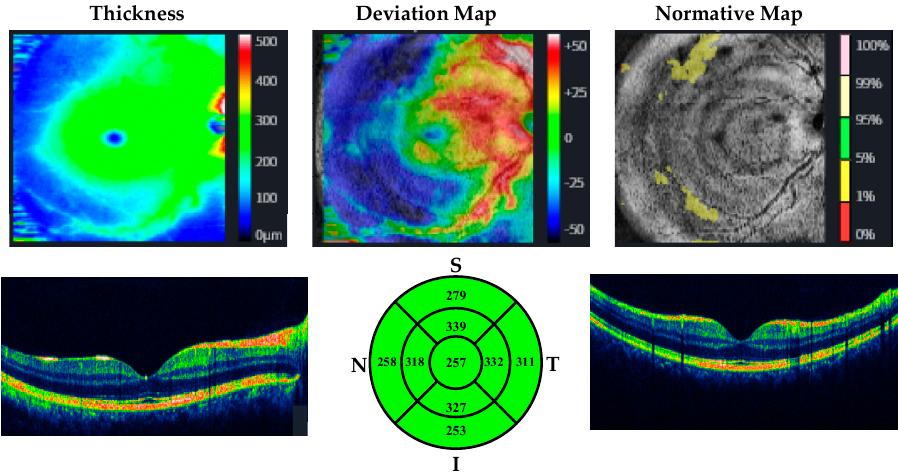
Figure 3. OCT analysis of the macula in a patient with methamphetamine use disorder.